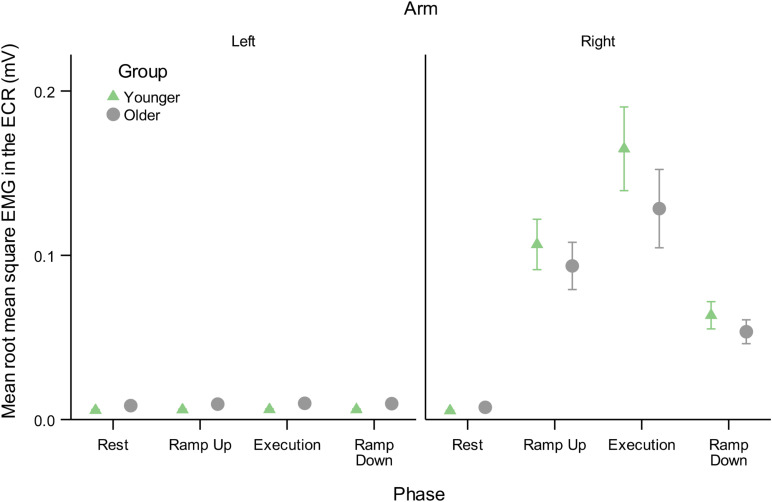
Mean root mean square of EMG background muscle activity in the resting L-ECR and active R-ECR across phases for younger and older participants. Error bars are ±1 SEM. For the R-ECR, all active phases of contraction were significantly different from each other and from rest (planned contrast t-tests, all p < 0.05, see section “Contraction Phase Rather Than Contraction Force Related to Active MEP Recruitment Amplitude”). There were no significant differences among any phases in the L-ECR [F(3,126) = 1.03, p = 0.38; see Table 6].